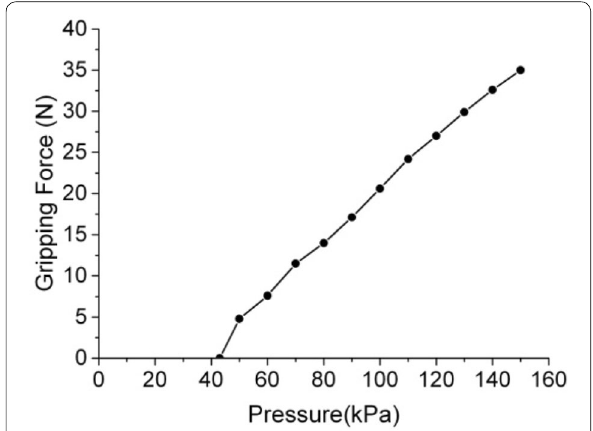
Figure 14 Largest gripping force of the E-Gripper under different working